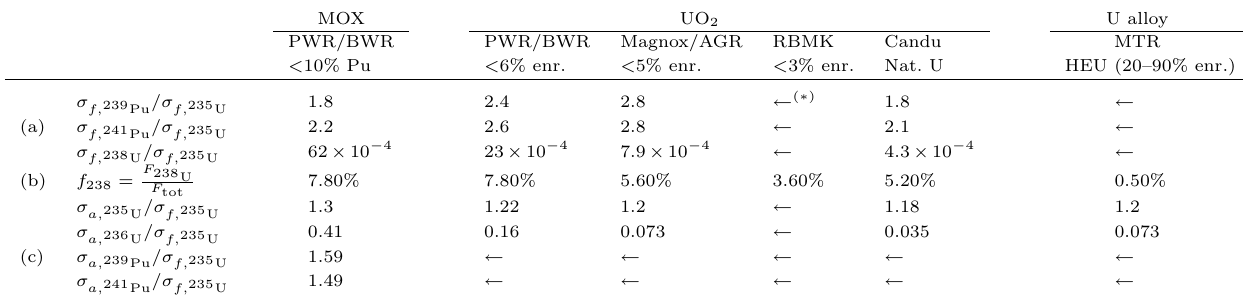
Table 2. Reactor-specific parameters for burnup monitors based methods: (a) effective fission cross-section ratios used in irradiation-averaged fission yield evaluation [14,16–18]; (b) 238 U contribution to fission and effective absorption cross sections used in the method proposed in Section 5.2; (c) effective absorption-to-fission cross-section ratios for use in the ASTM E244 and E321 methods [13,30].